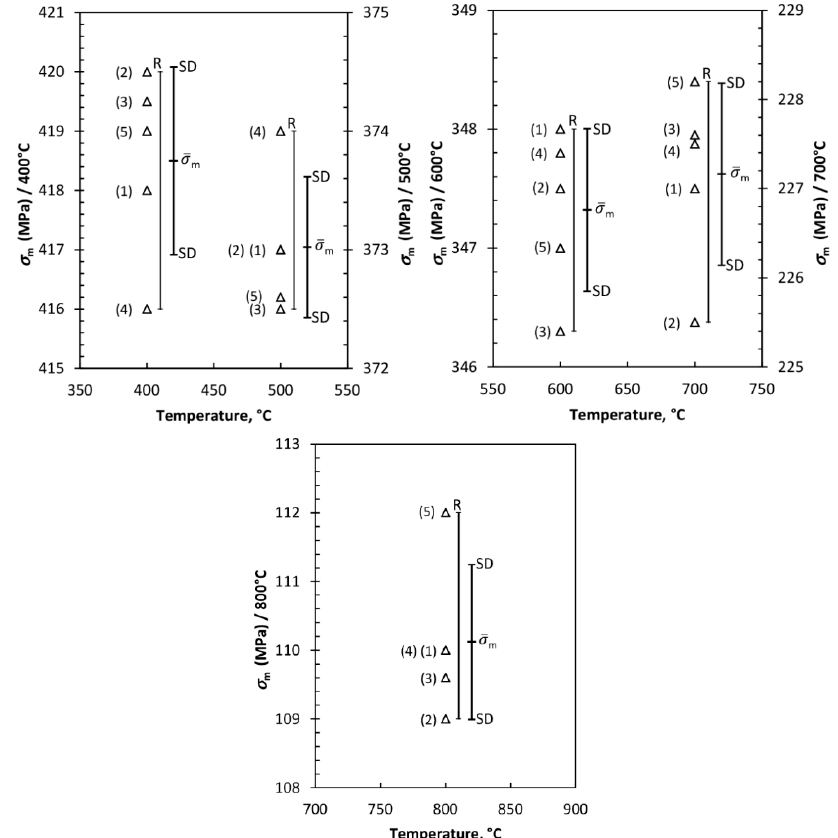
Figure 4. Descriptive error bars: Ultimate tensile strength of steel X6CrNiTi18-10. (The small triangles are experimental data points (test results), while R = range; SD = standard deviation; i = a number of the test, n = the total number of tests).